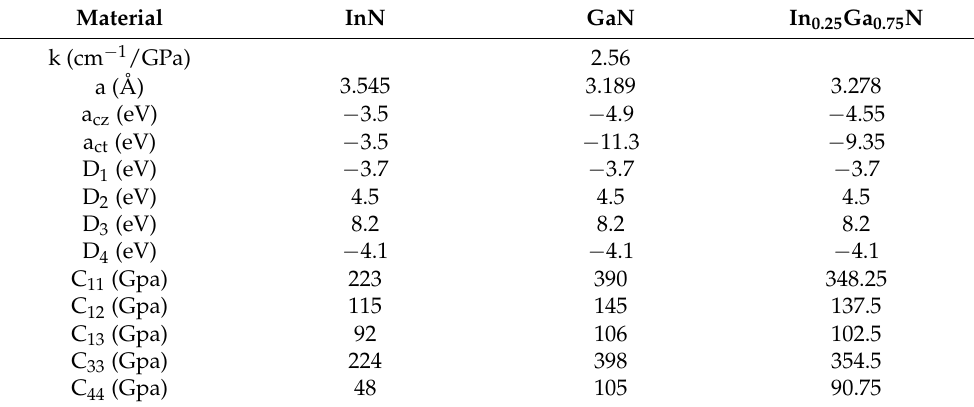
Table 1. Parameters used for GaN and InGaN materials stress and strain analysis